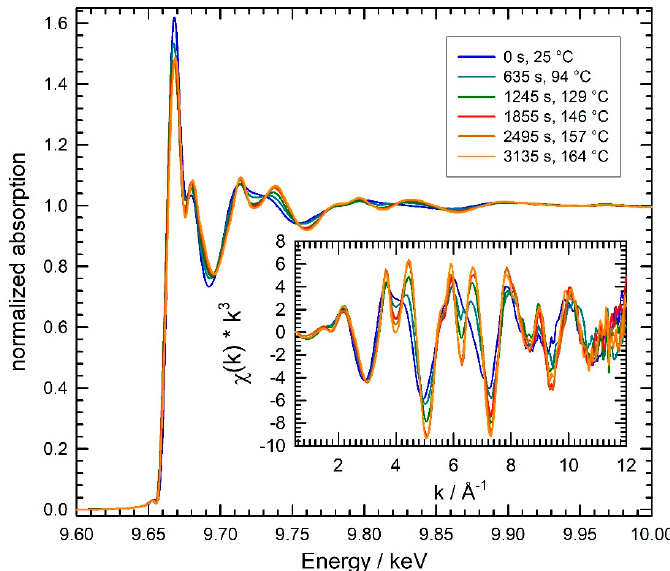
Figure 3. Selection of characteristic Zn K-edge X-ray absorption data measured during the heating of a Zn(acac) 2 solution in 1-octanol from room temperature to ca. 165 °C as indicated (sample O). The k 3 -weighted EXAFS χ (k)*k 3 extracted from the data is depicted in the inset. Most notable is the presence of isosbestic points in the absorption spectra at ca. 9.677 keV, 9.711 keV, 9.732 keV, 9.752 keV and 9.822 keV. In the χ (k)*k 3 data (inset of Figure 3),